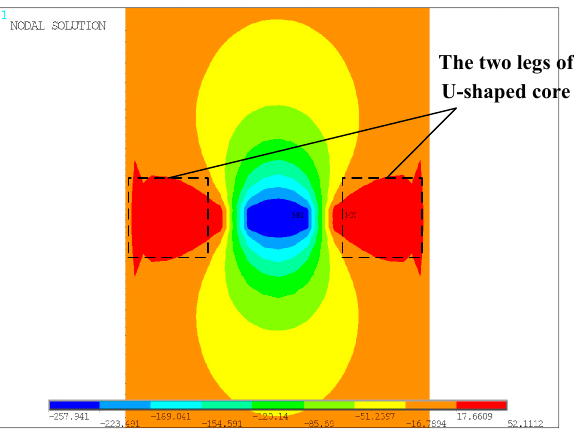
Figure 6. Cloud diagram of magnetic field intensity distribution on the pipe surface.